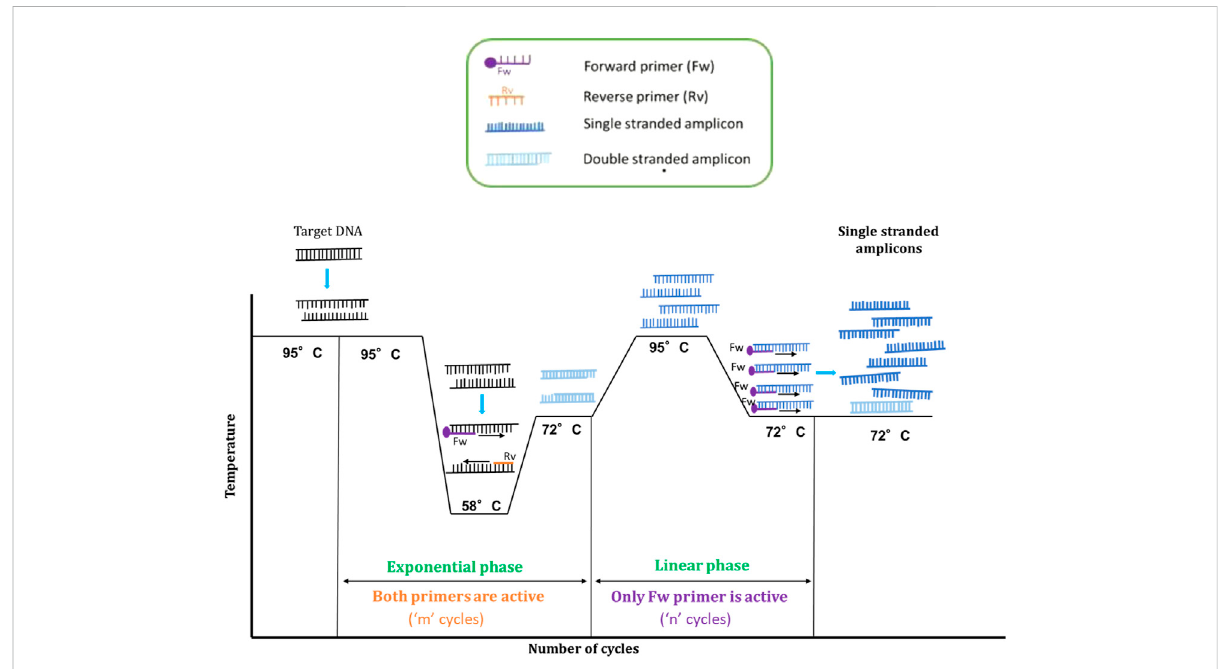
FIGURE 2 Schematic representation of AELA-PCR thermal pro fi le. The target ds-DNA is denatured and then annealed at 58 ° C to bind with Forward (Fw) and Reverse (Rv) primers in order to synthesize new complementary strands. These new strands are extended resulting in two ds-DNA fragments. The new strands are themselves extended at the side where the extended primers had been elongated to get an inverted self complementary tail sequence. The newly obtained strands are then denatured and reannealed for the linear phase at a higher temperature than the annealing temperatureof theexponential phase. As a consequence, only theextended primer will be active for sequence elongation during the linear phase. It meansthat as awhole, theresulting product will beenriched insingle strandedDNAofone thestrands oftheDNA target (single stranded amplicons aredepictedindarkblueanddoublestrandedampliconsinlightblue).Therequiredampli fi cationcyclesateachphase “ m ” and “ n ” canbebalancedas discussed in guard banding studies.